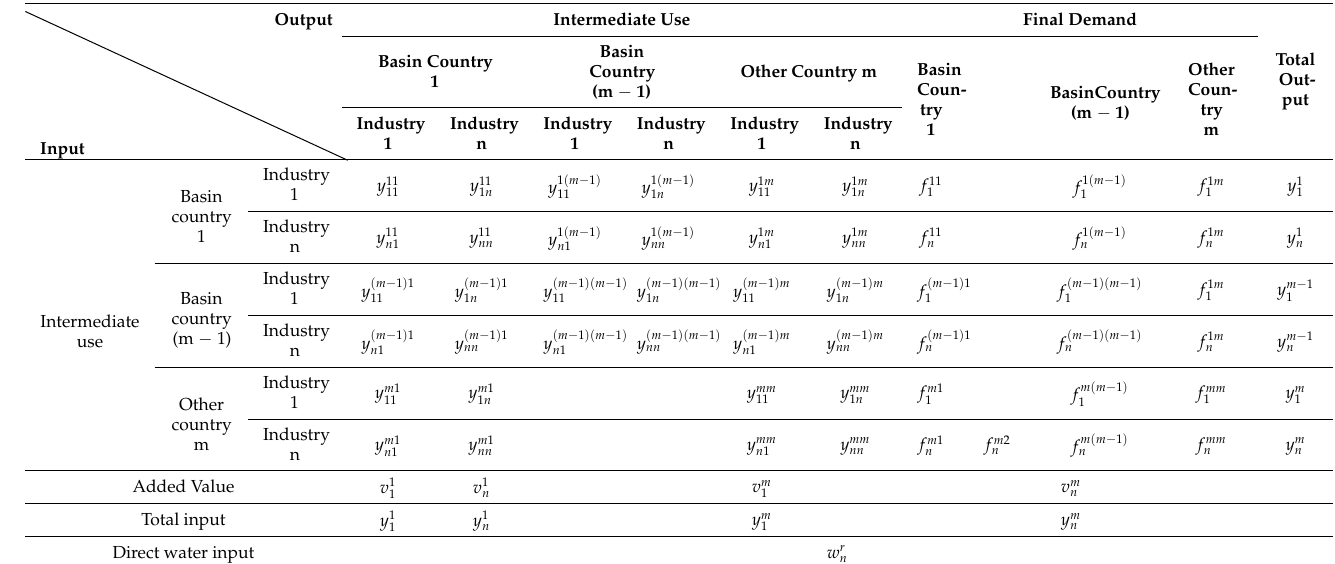
Table A1. The modified multi-regional input–output table.